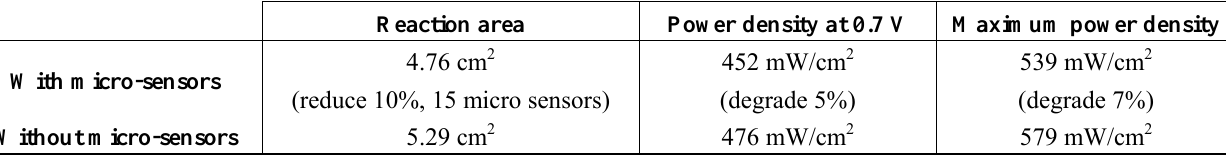
Table 2. Comparison of reaction area, power density without and with micro